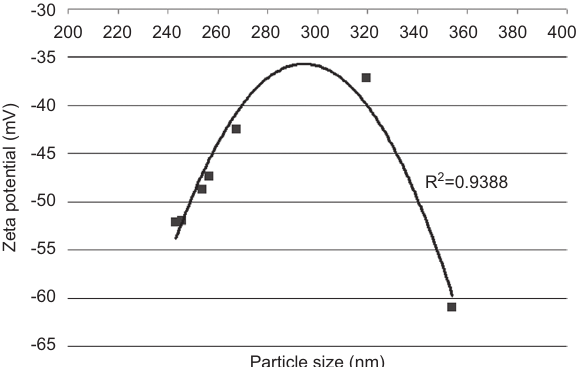
Figure 10 Zeta potential response in terms of the particle size response in optimum